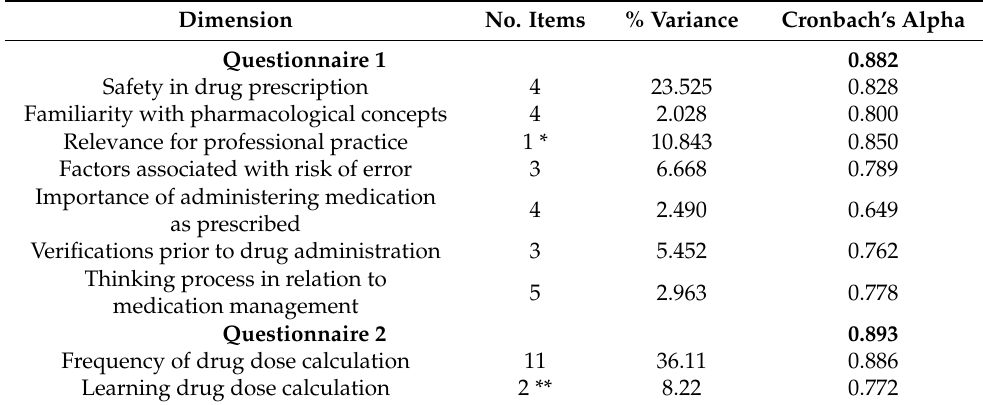
Table 3. Summary of the results obtained for the dimensions of the two questionnaires. Dimension No. Items % Variance Cronbach’s Alpha Questionnaire 1 0.882